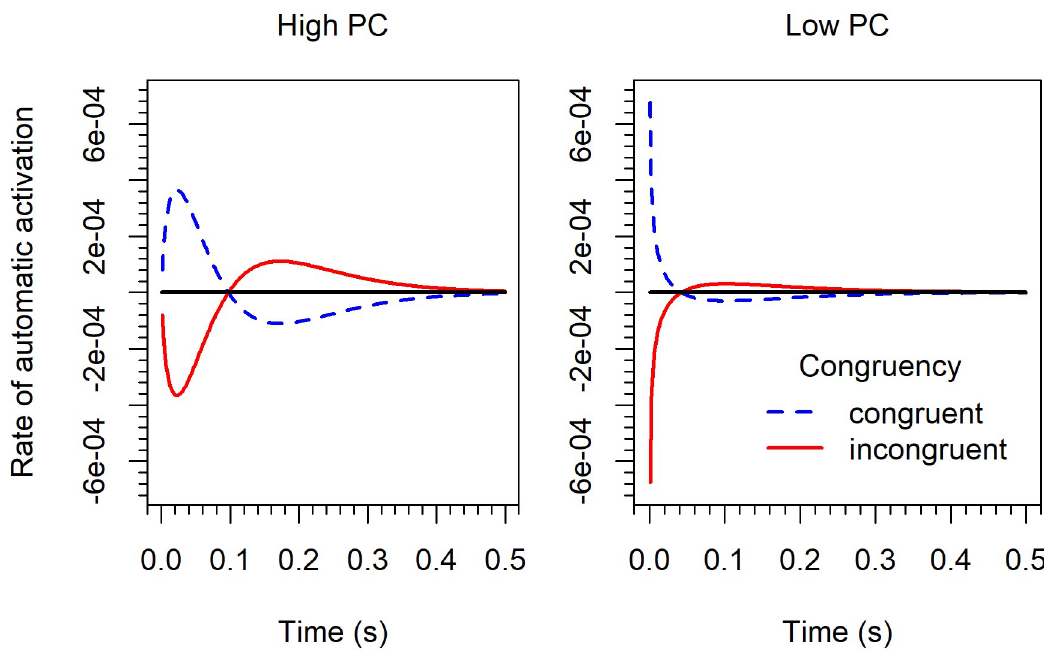
Fig 13. The rate ( μ a ( t )/1000) of the automatic process in the DMC model for the LPC and the HPC condition in Experiment 3 (Simon task).